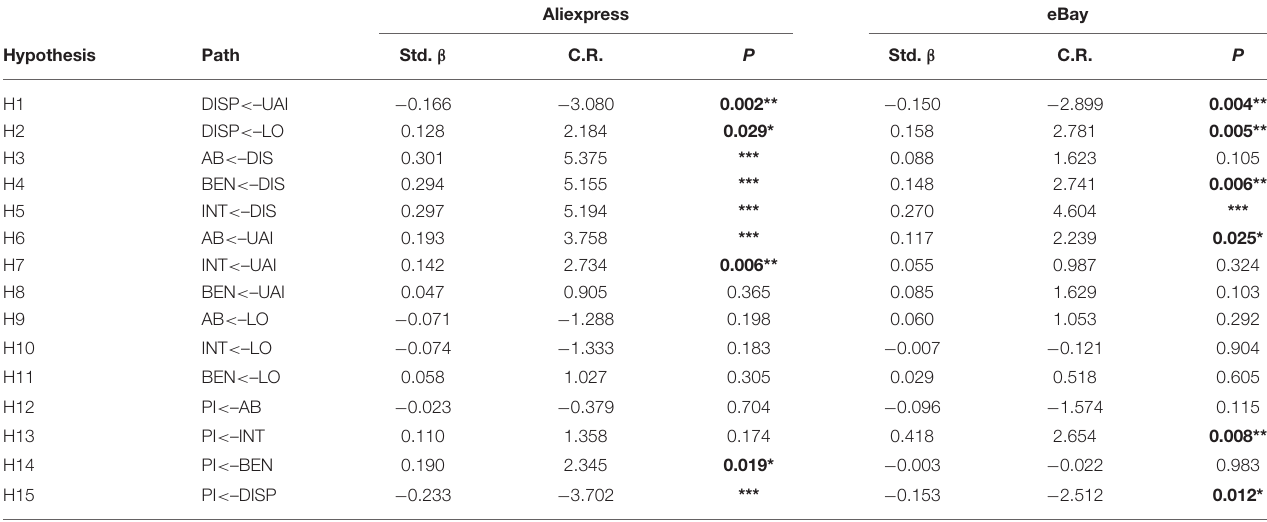
TABLE 5 | Results of hypothesized effect.